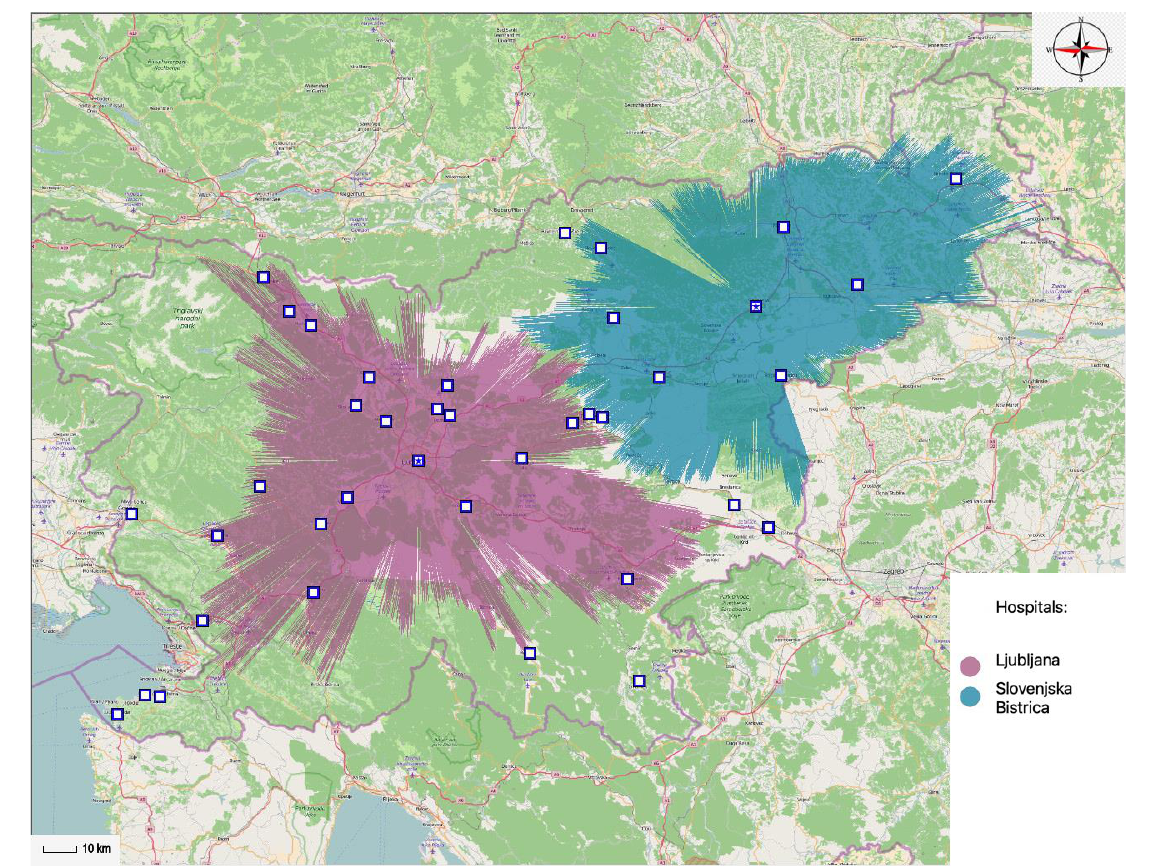
Figure 8. Optimal locations of two different general hospitals within the 60-min time interval. Table 3. Number of general hospitals and a coverage rate of the population within the 60-min time interval.